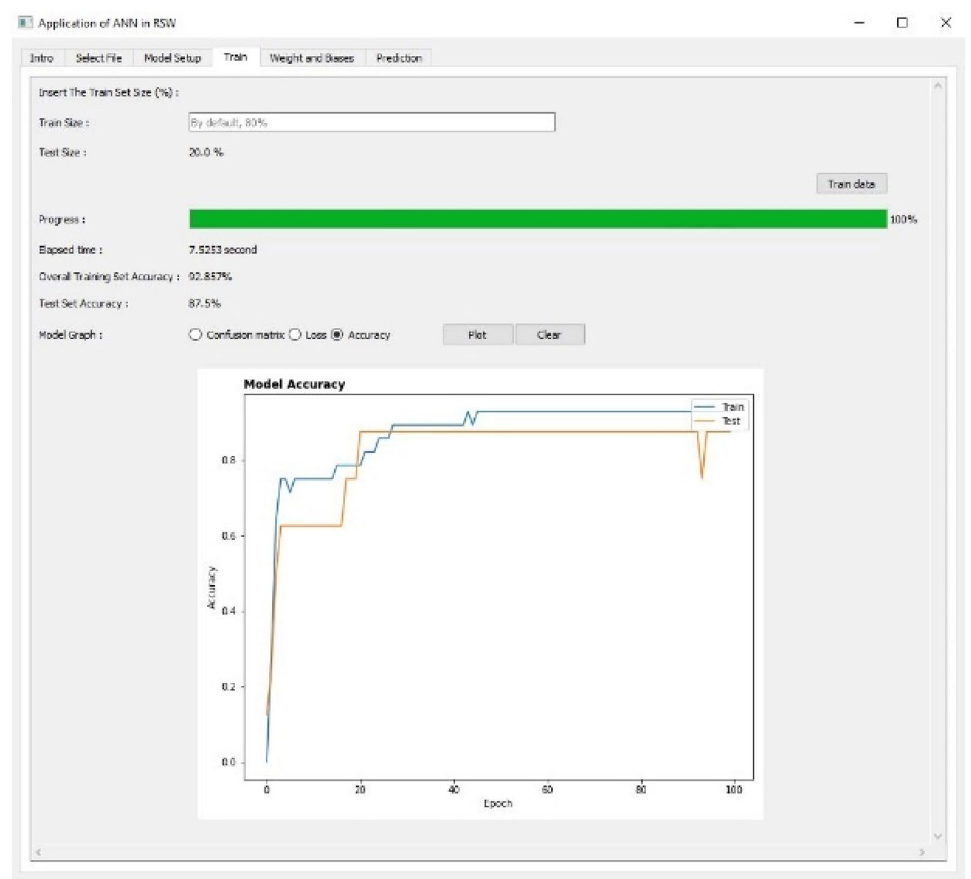
Figure 10. Training and evaluating the ANN model using Accuracy as Tab 4.